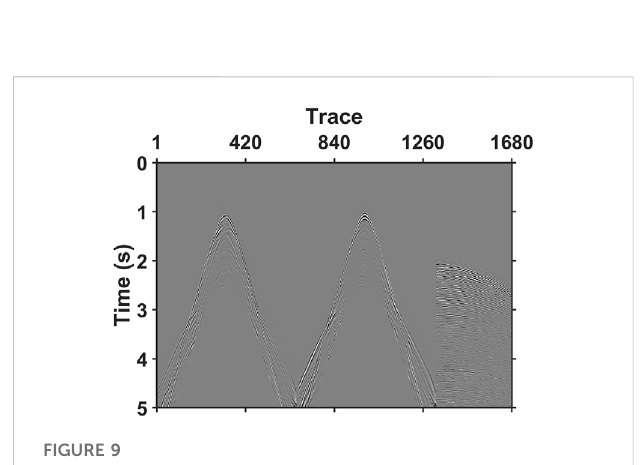
The x , z -component data of OBS and towed streamer